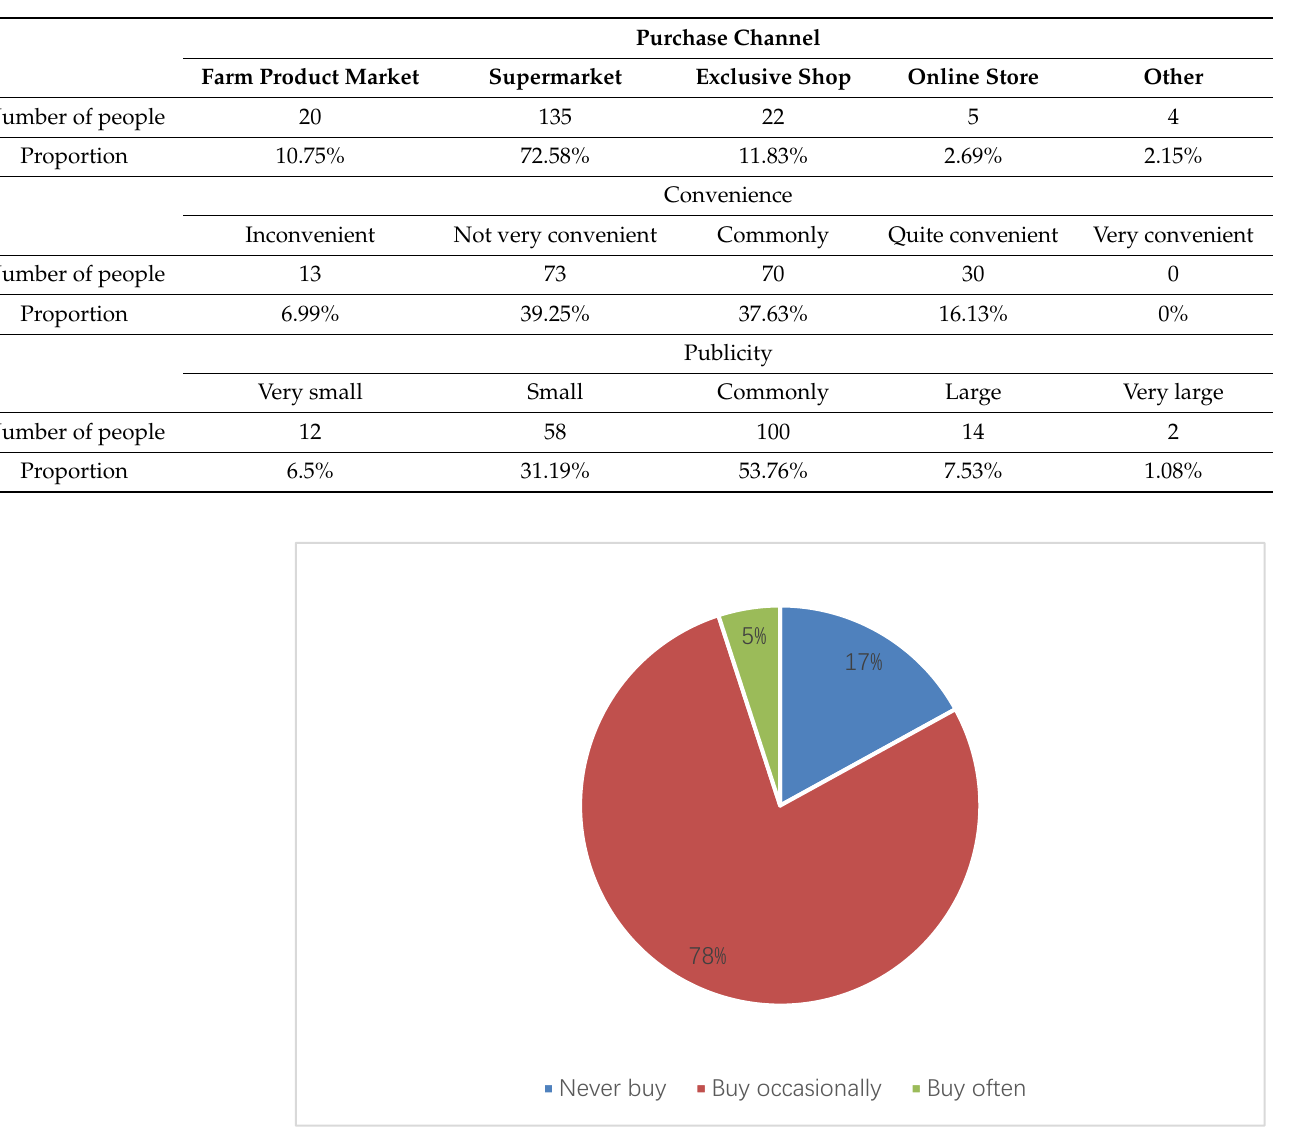
Figure 17. Consumers’ purchase frequency of organic agricultural products.